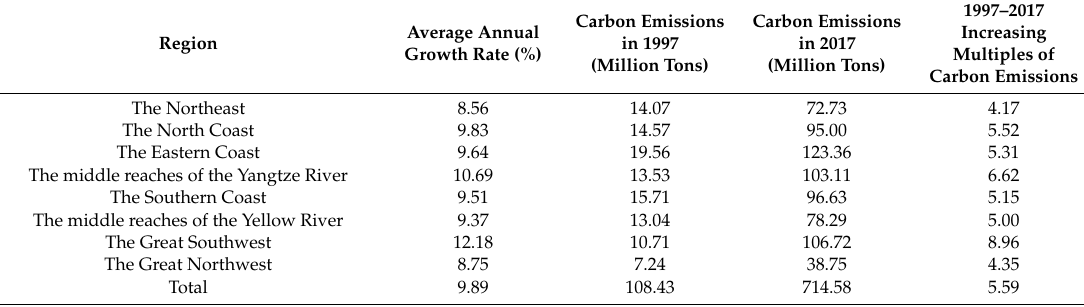
Figure 2. CO 2 emissions in the transportation industry in the eight regions of China from 1997 to 2017. Table 2. Carbon emissions of the transportation industry in eight Chinese regions.